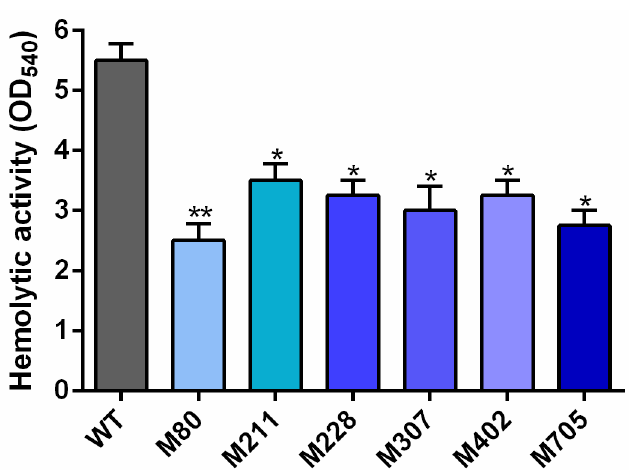
Figure 1. Hemolytic activity of the mutants compared to the wild-type strain. A total of six mutants were identified based on their hemolytic activities. * p < 0.05 or ** p < 0.01.